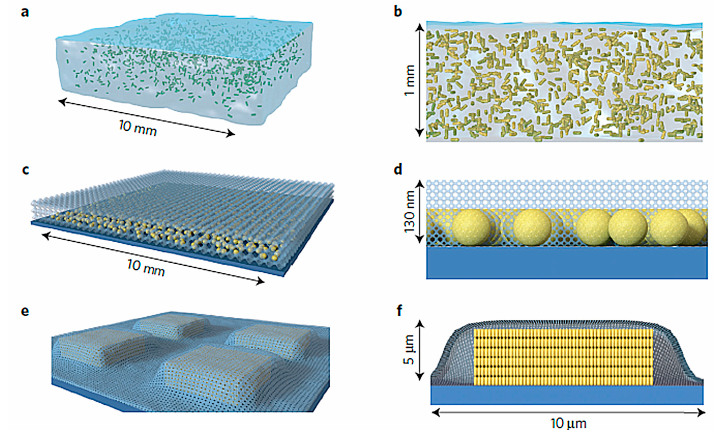
Figure 3. Schematic representation of nanostructured porous substrates for in situ plasmonic detection and imaging of QS in Pseudomonas aeruginosa biofilms. ( a , b ) Au@pNIPAM hydrogel with embedded Au nanorods (drawn in green). ( c , d ) Mesostructured Au@TiO 2 substrate with a mesoporous TiO 2 thin film over a submonolayer of Au nanospheres. ( e,f ) Micropatterned Au@SiO 2 supercrystal array comprising Au nanorods organized in micrometer-sized pedestal-like structures coated